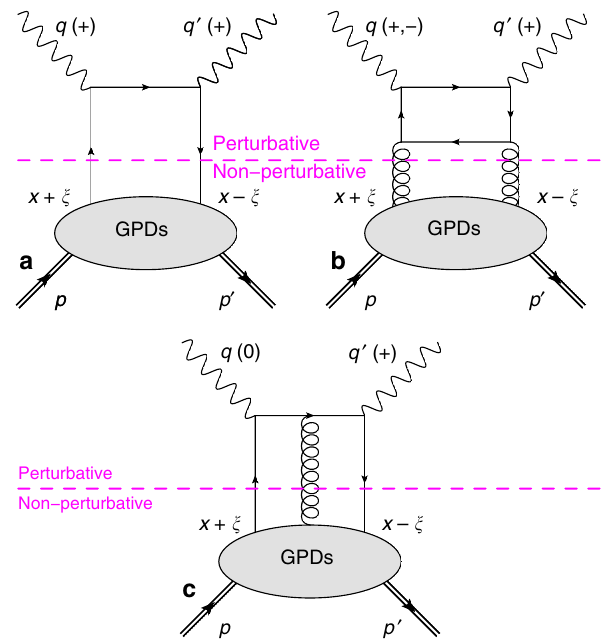
Fig. 1 A few examples of DVCS diagrams. At leading-order in perturbative quantum chromodynamics (QCD) ( a ), the virtual photon with four- momentum q interacts with a single quark (single straight line) from the proton p , in the limit Q 2 = − q 2 much larger than the proton mass